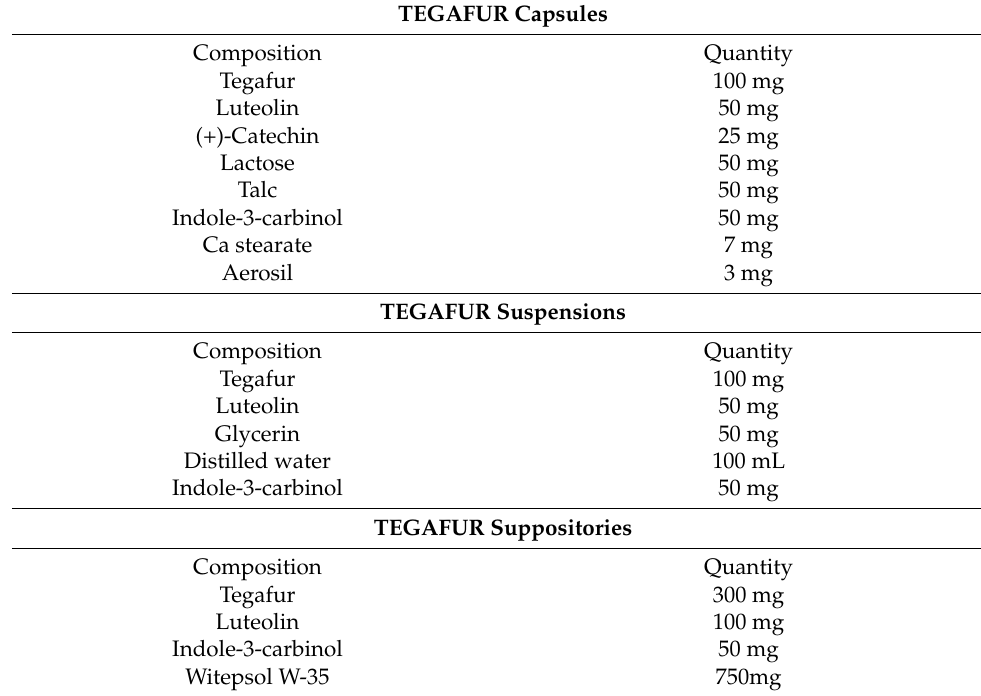
Table 2. Composition of the patent for TEGAFUR and chemotherapeutics